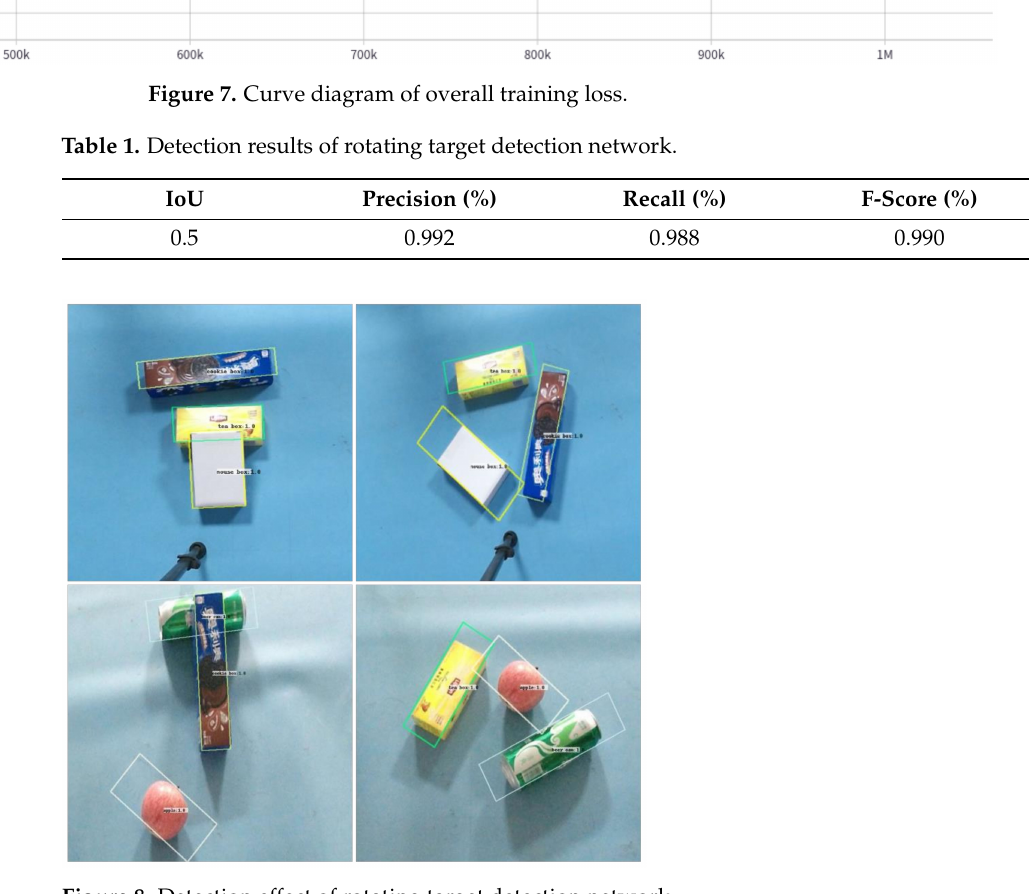
Figure 8. Detection effect of rotating target detection